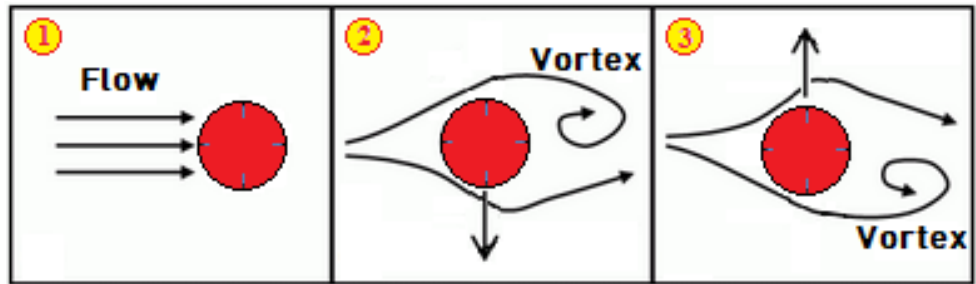
Figure 2. Direction of the exerted force when vortices shed from the cylinder. A typical VIV setup consists of a cylinder connected to the main frame by two elastic springs. The cylinder is totally submerged in water and constrained to move only in the axis. An illustrative drawing is given in Figure 3.